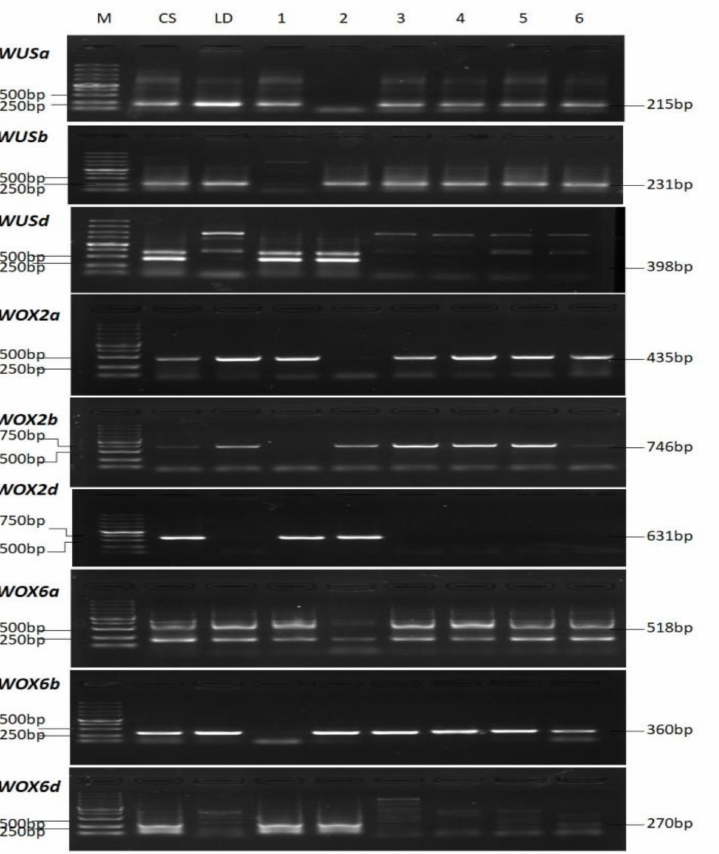
Figure 3. Verification of chromosomal locations of several TaWOX alleles by specific PCR amplification. Gel electrophoresis of specific fragments of TaWUS , TaWOX2 and TaWOX6 alleles. M, DNA molecular marker; CS, PCR product of Chinese Spring ( T. aestivum ); LD, PCR product of Langdon ( T. durum ) ; samples 1–6 in row WUSa were: substitution lines 2D(2B), 2D(2A), 1D(1A), 3D(3A), 4D(4A), and 5D(5A); samples 1–6 in row WUSb were: 2D(2B), 2D(2A), 1D(1B), 3D(3B), 4D(4B), and 5D(5B);